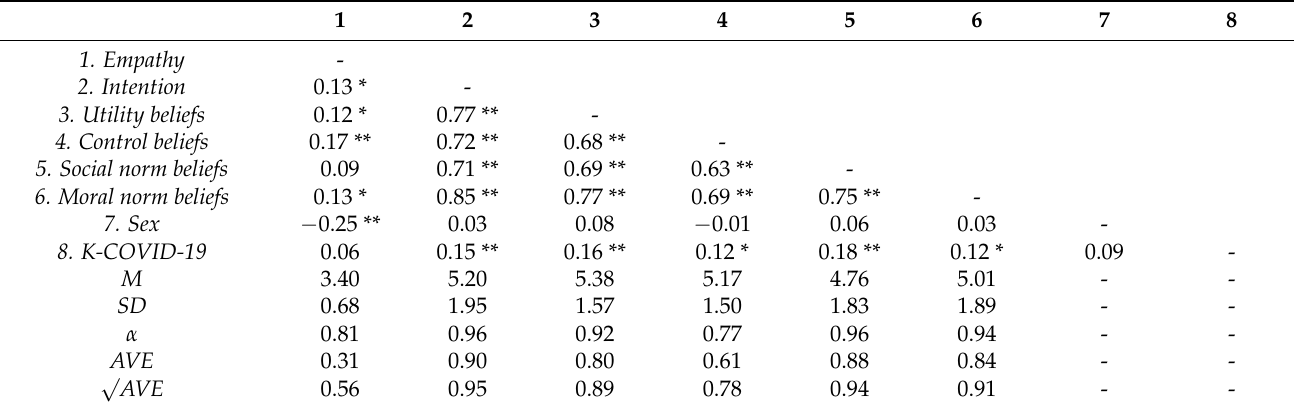
Table 4. Spearman’s rho, means, standard deviations, and average variance were extracted in Study